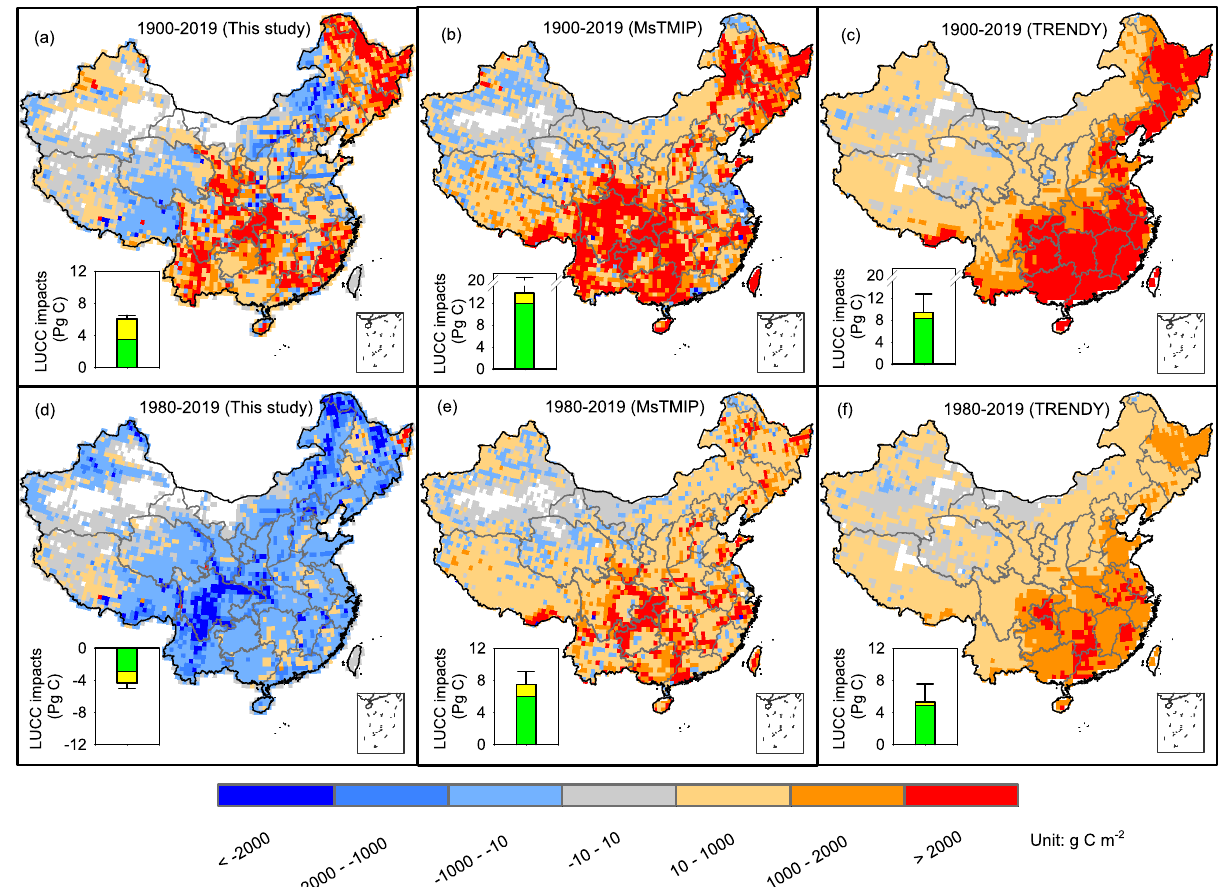
Fig. 4 | Spatial distribution of LUCC impacts on ecosystem carbon storage. Panel a – c : LUCC impacts for period of 1900 – 2019; panel d – f : LUCC impacts for periodof1980 – 2019 ( d – f ).Panels a and d are from this study; data in panels b and e are from MsTMIP; data in panels c and f are from TRENDY; negative and positive